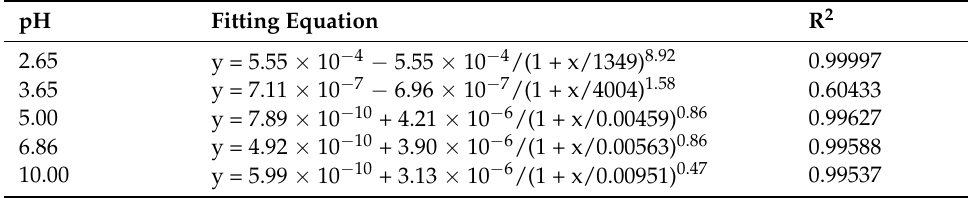
Table 2. Fitting results for hydraulic conductivity under different pH